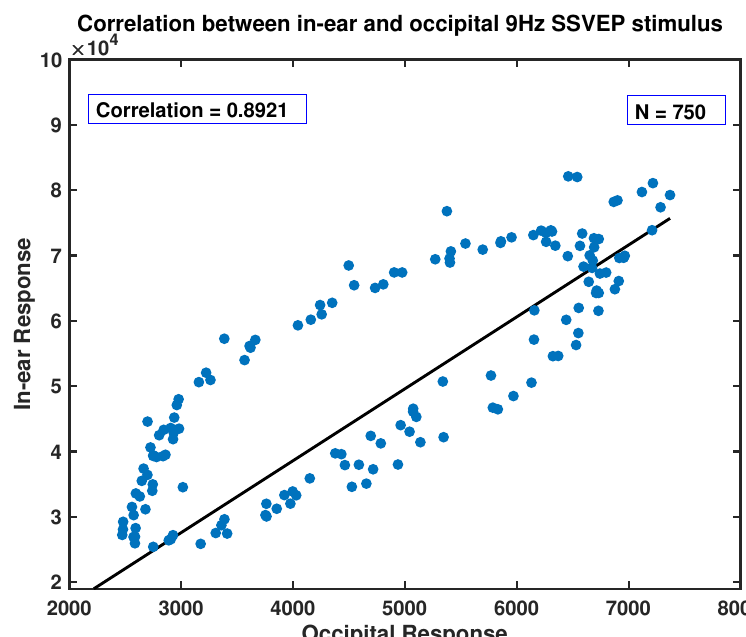
Figure 13. Scatter plot showing the correlation between occipital and in-ear